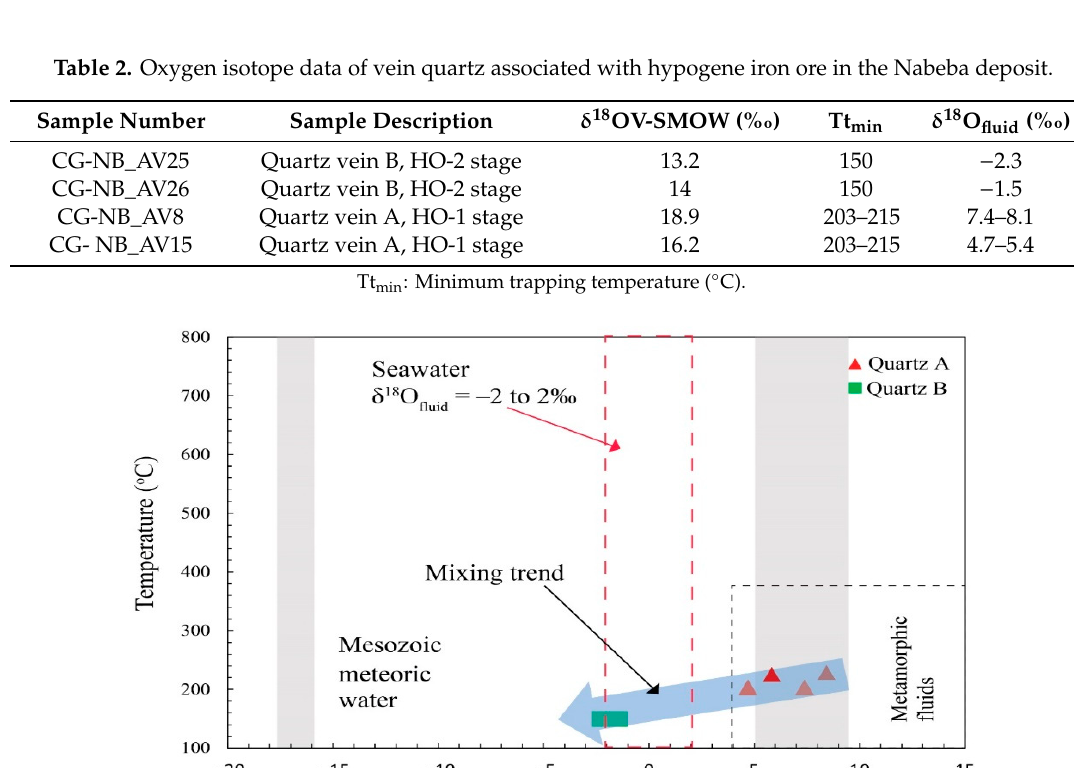
Figure 11. Representative Raman spectra of fluid inclusions in vein quartz associated with hypogene iron ore of the Nabeba deposit. ( a ) H 2 O and CO 2 spectra of the vapor phase in the Type IIIb fluid inclusion in quartz vein A (HO-1 stage); ( b ) CO 2 spectrum of vapor phase in Type I fluid inclusion in quartz vein A (HO-1 stage). 4.4. Oxygen Isotopes Quartz veins A and B yielded (cid:2012) 18 O values of 16.2–18.9‰ and 13.2–14‰, respectively (Table 2). The δ 18 O fluid values for water in equilibrium with quartz, calculated using the equation of Clayton et